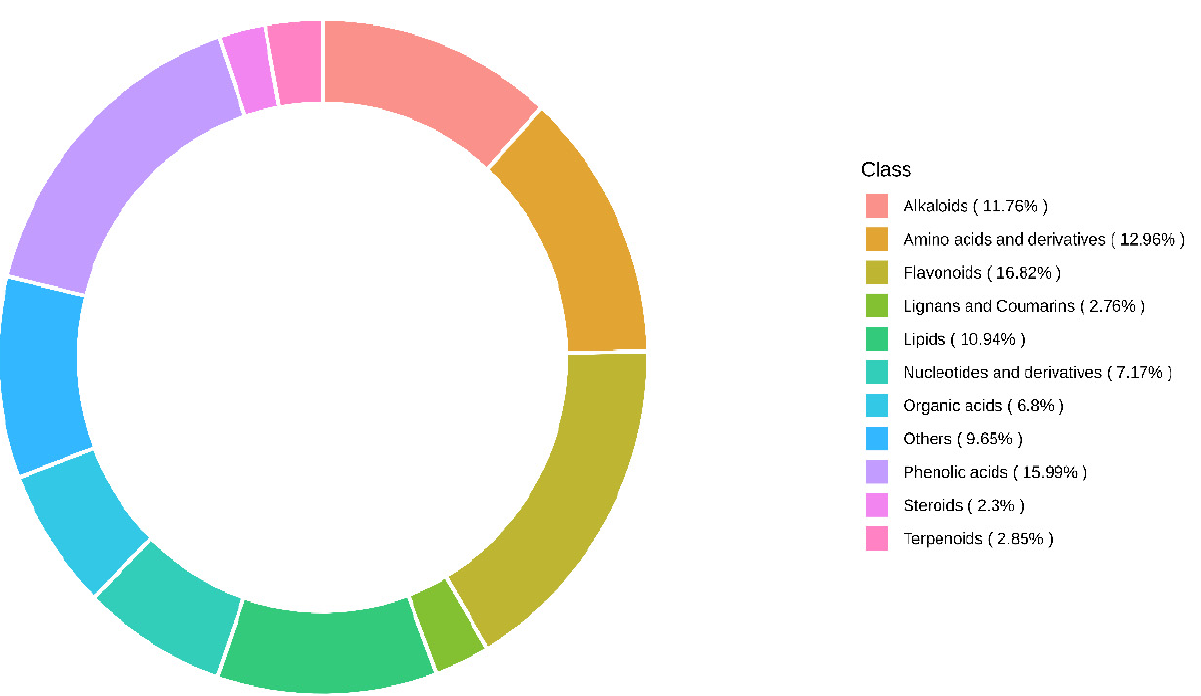
Figure 2. Proportion of different classes of compounds for the metabolites detected from jalapeño and serrano chile peppers using a widely targeted metabolomics approach.